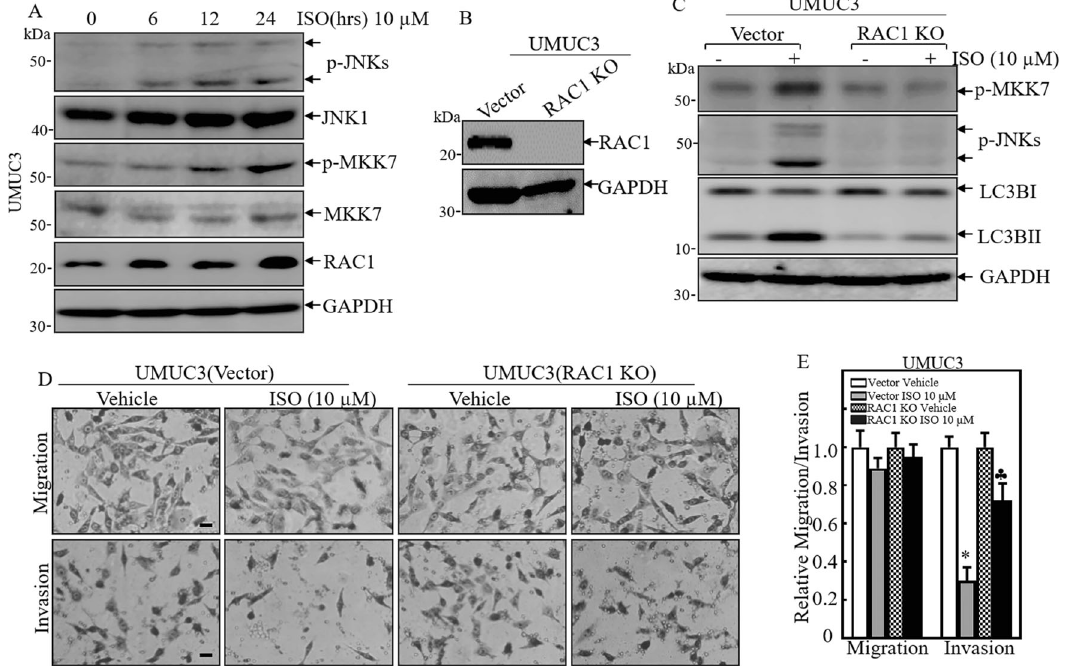
Fig. 1 ISO treatment promoted RAC1 expression to induce autophagy and invasion inhibition in human invasive BC cells. A UMUC3 cells were treated with 10 μ M of ISO for indicated time periods. The cells were then extracted and cell lysates were subjected to Western blot using the indicated antibodies. B CRISPR Cas9 for RAC1 was stably transfected into UMUC3 cells, and the stable clones were identi fi ed with Western blot. C The indicated stable cells were subjected to 10 μ M of ISO treatment for 24 h for determination of the indicated proteins in UMUC3 cells. D UMUC3(RAC1 KO) and UMUC3(Vector) cells were subjected to transwell assay in medium containing either vehicle or 10 μ M of ISO for 24 h. Representative images were captured under a microscope. E The invasion and migration rates were quanti fi ed by counting the relative migrated (Transwell) and invaded cells at least three random fi elds under a light microscope, and the bars show Mean ± SD from 3 independent experiments. The scale bar was 200 μ M. * Signi fi cant decrease from vehicle control ( p < 0.05), ♣ Signi fi cant increase from UNUC3(Vector) treated with ISO ( p <